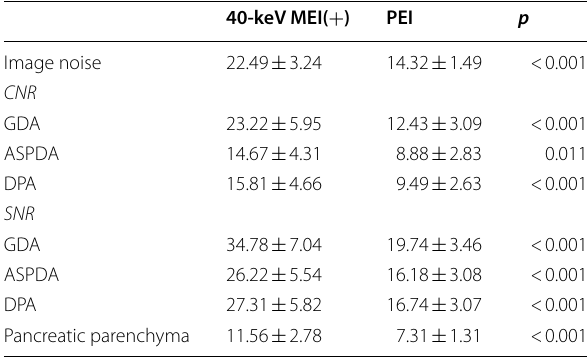
) and PEI. The box indicates the 25‑ and 75‑quartile; +